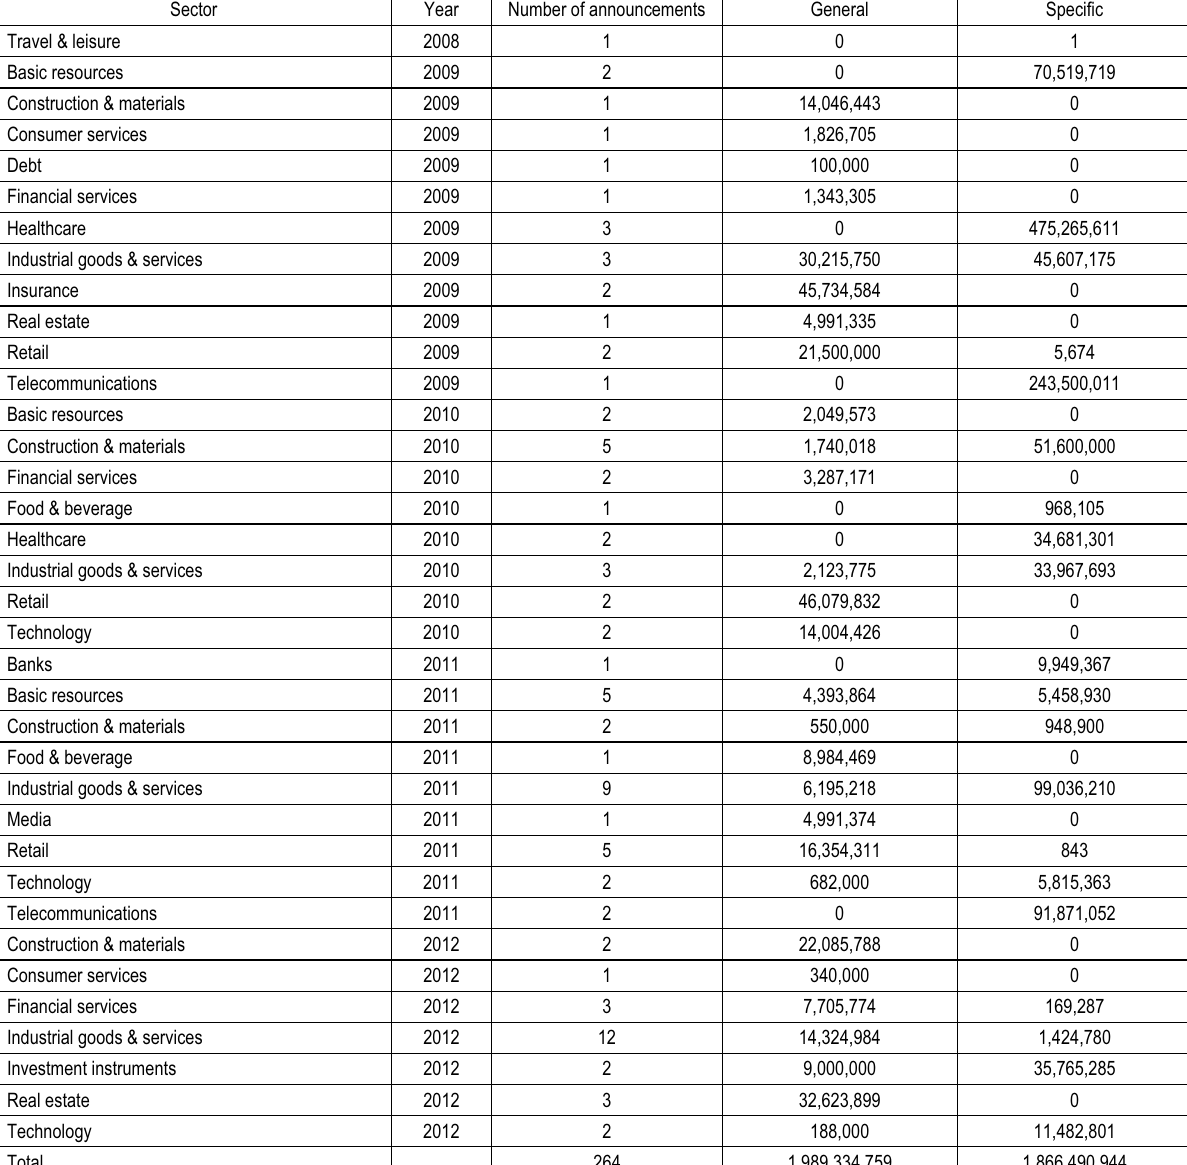
Table 2 (cont.). Total share repurchase announcements per sector per calendar year for the population Sector